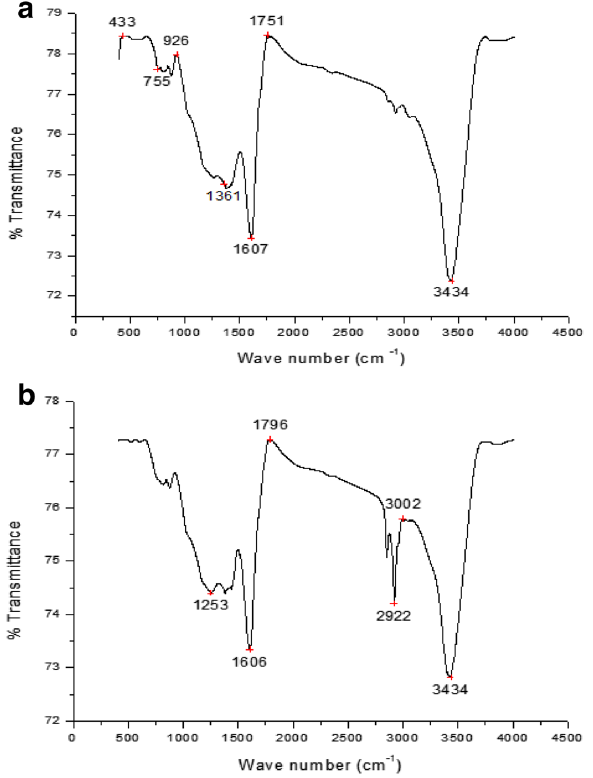
Fig. 4 FTIR spectra of a CCSFP and b fluoride-loaded CCSFP